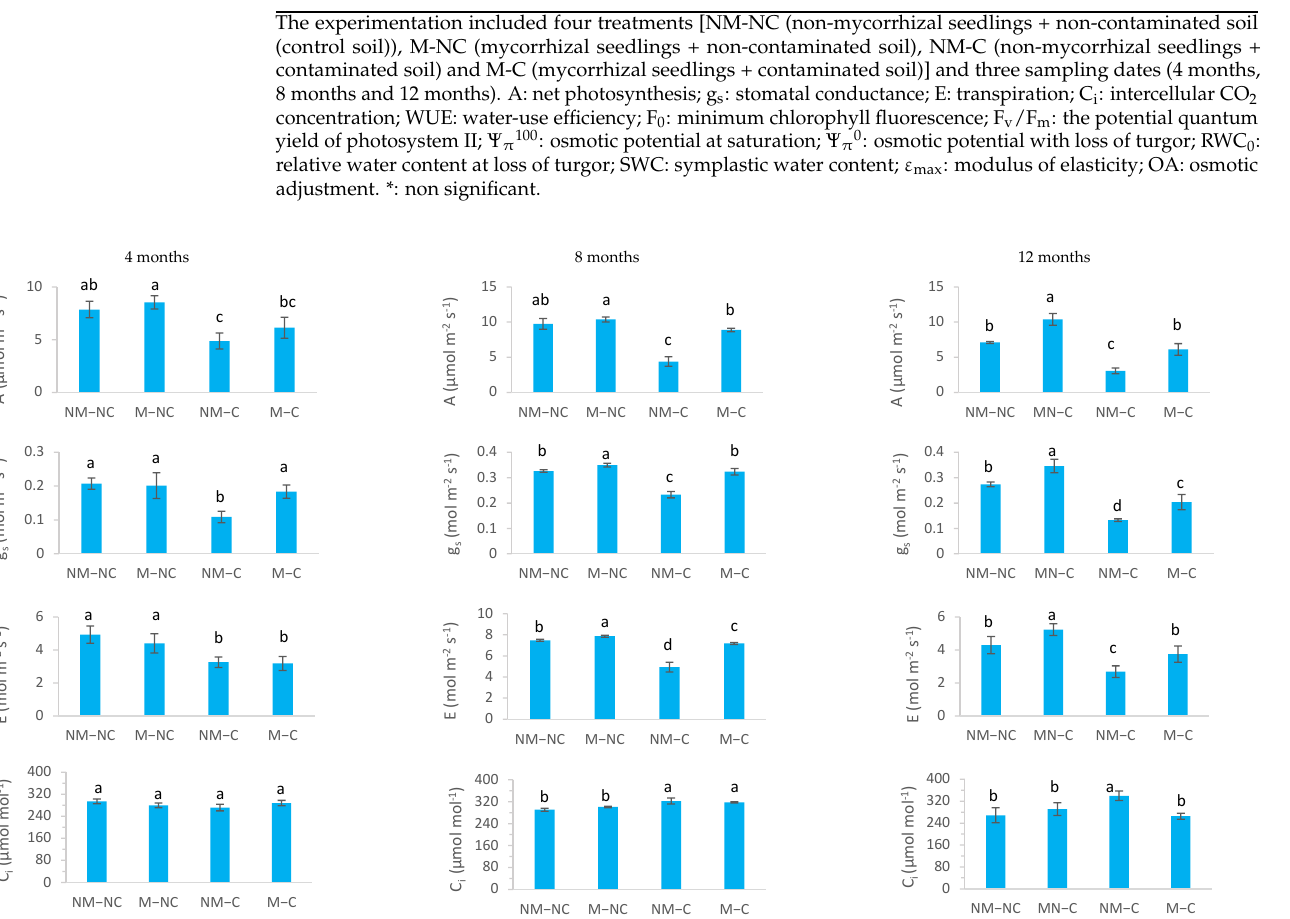
Figure 2. Net photosynthesis (A), stomatal conductance (g s ), transpiration (E) and intercellular CO 2 concentration (C i ) of ectomycorrhizal (M) and non-ectomycorrhizal (NM) Pinus halepensis seedlings after 4, 8 and 12 months of growth in contaminated (C) and control or non-contaminated soil (NC). Means (± SD; n = 20) with different letters significantly differ from one another based on Tukey’s tests at p ≤ 0.05.